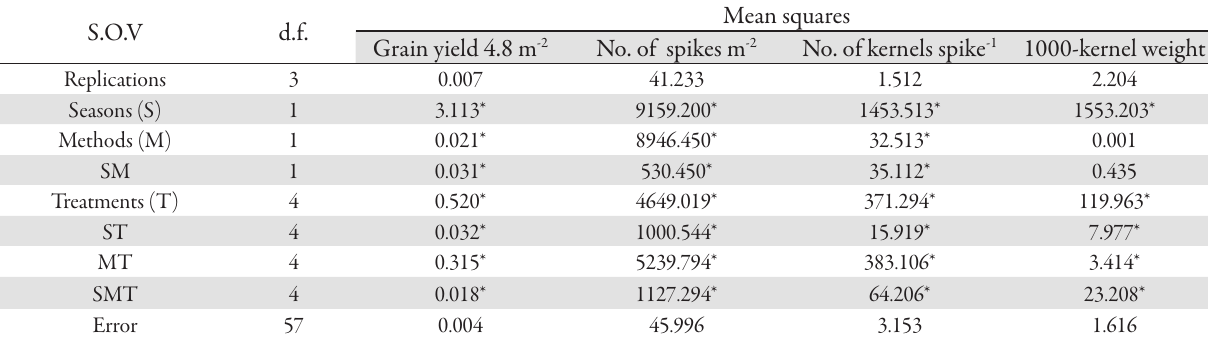
Tab. 6. Mean square analysis of four characters for ‘Bani Suif 5’ durum wheat cultivar using bio-control agents by soil and grain methods in 2009/2010 and 2010/2011